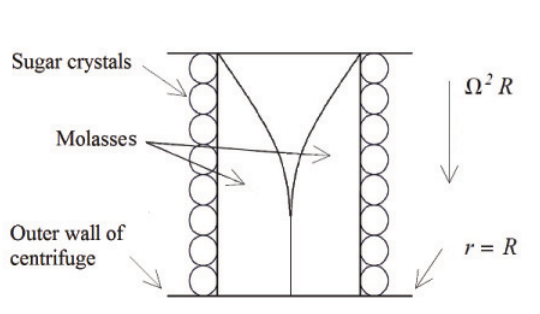
Figure 2. Drainage of molasses from crystals.